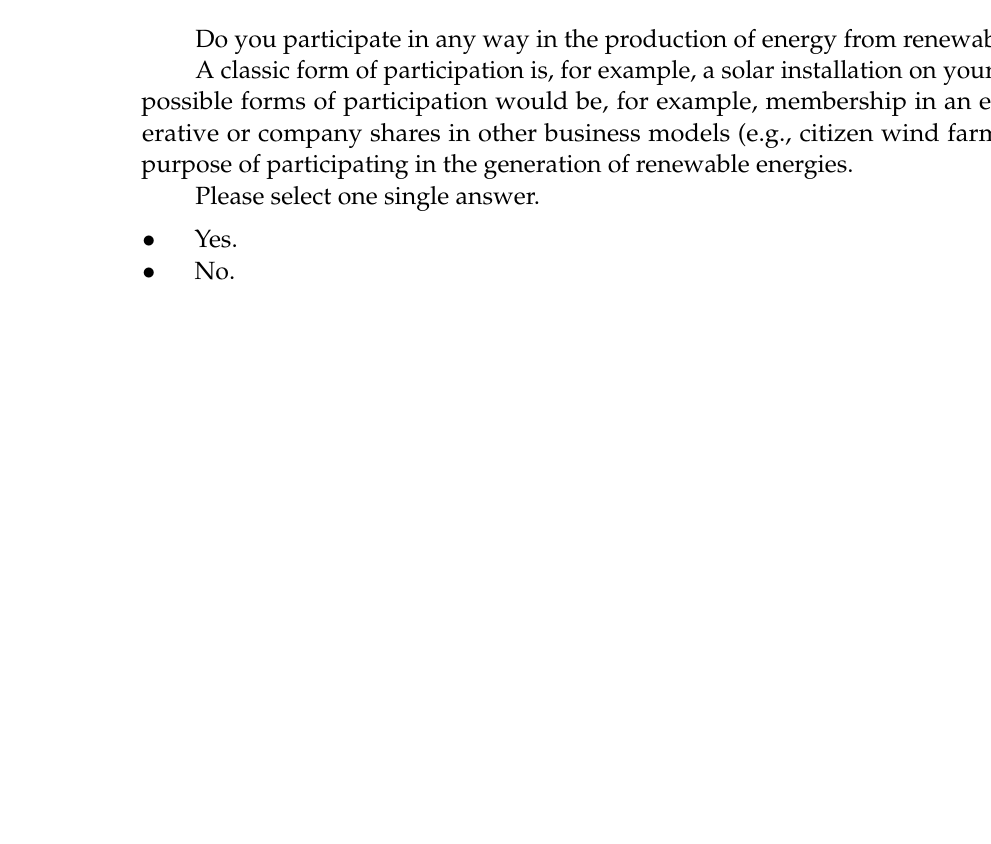
Figure A5. Screenshot of Questionnaire Page 4.